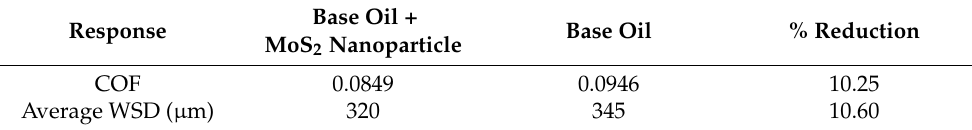
Table 8. The model validation for the MoS 2 nanolubricants.